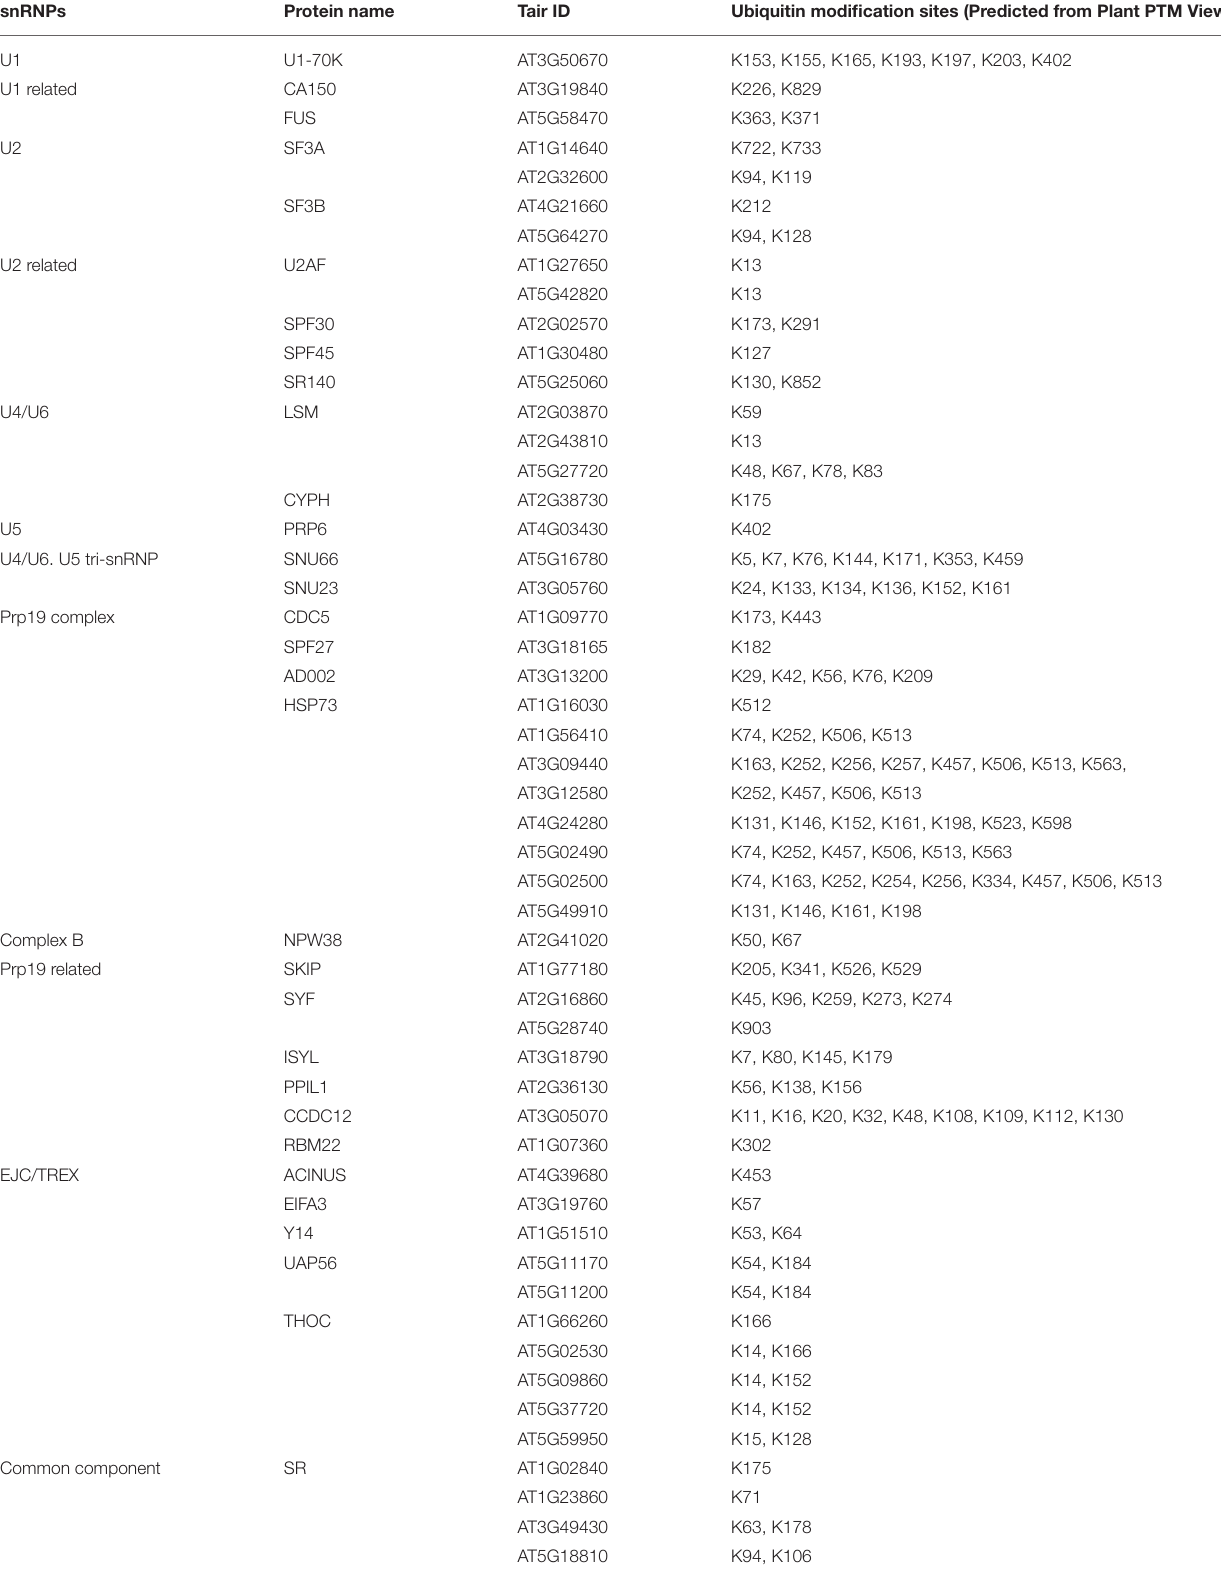
TABLE 1 | Potential ubiquitination sites in Arabidopsis spliceosomal